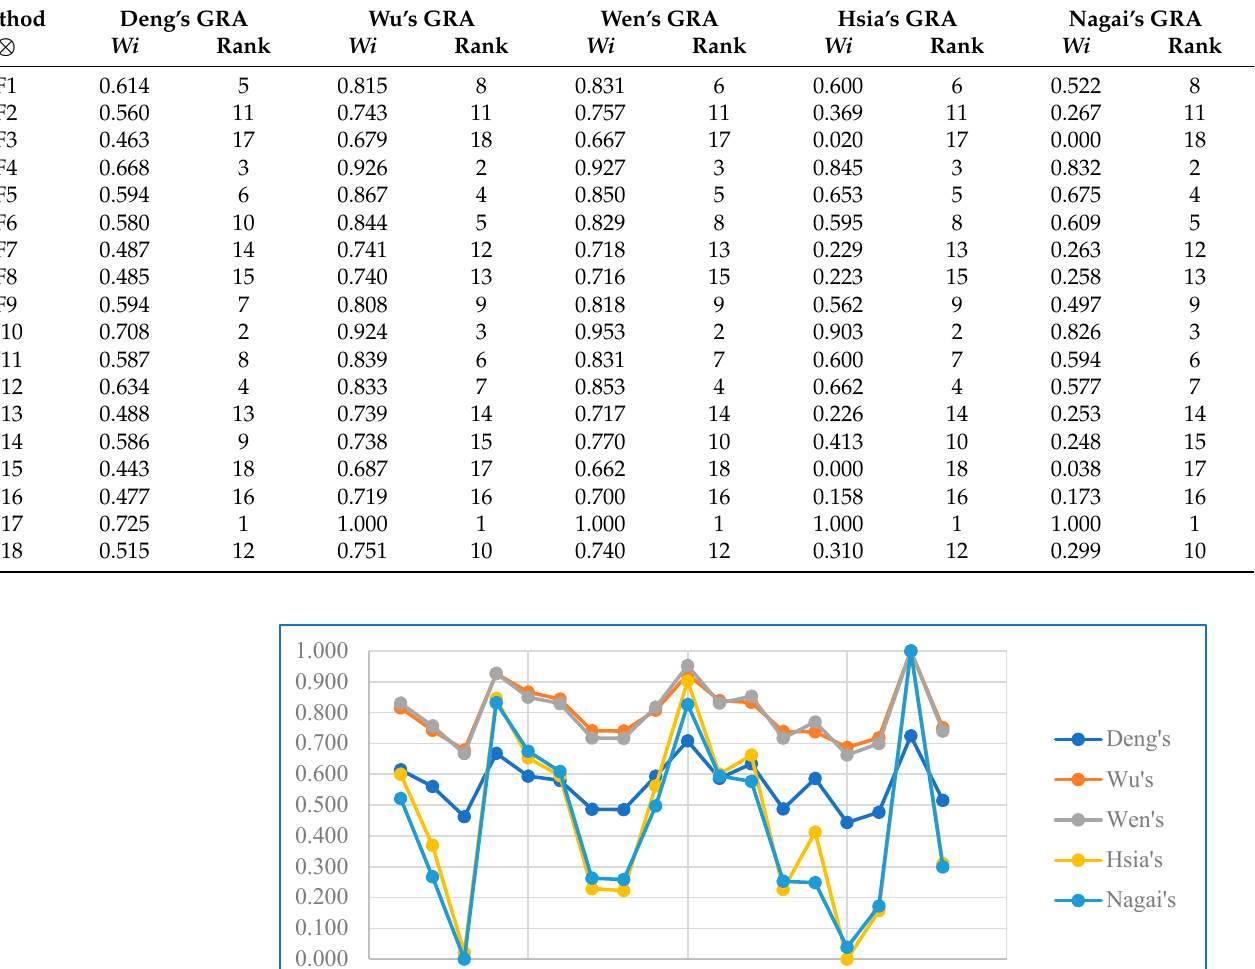
Table 10. Results of the five different GRA methods.